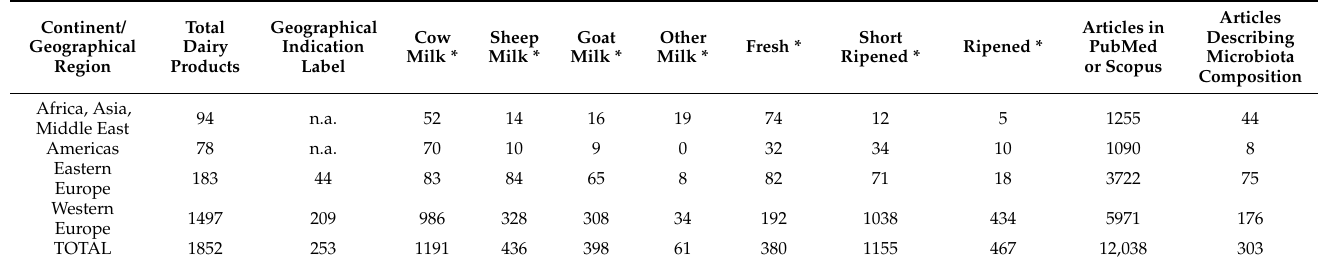
Table 2. Overall distribution of identified traditional dairy products, along with their characteristics and related articles, within continents or geographical regions.